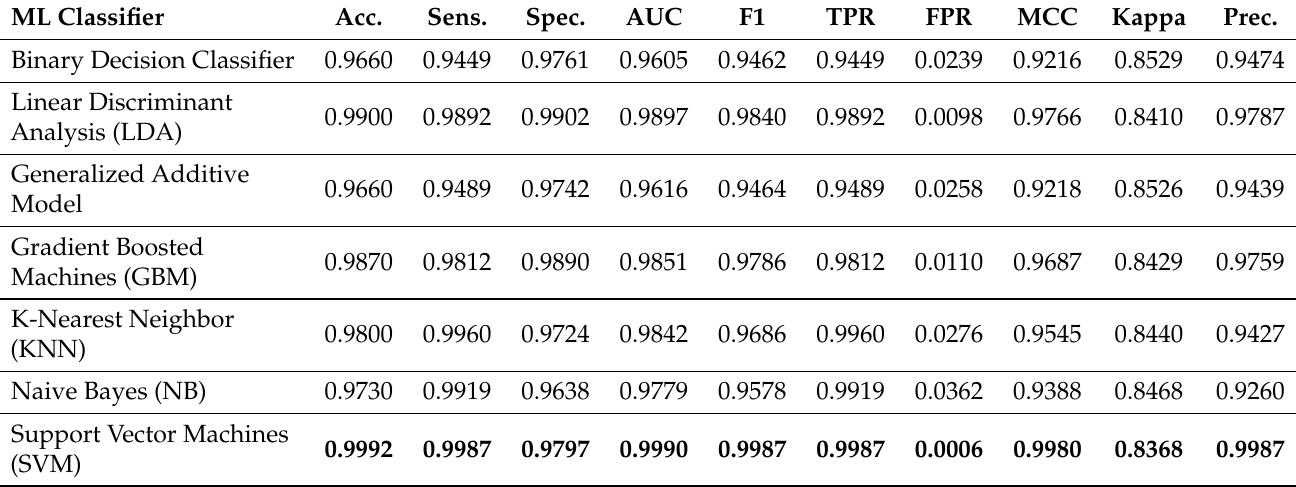
Table 13. Results of classifying the BoDMCF with various machine learning (ML)